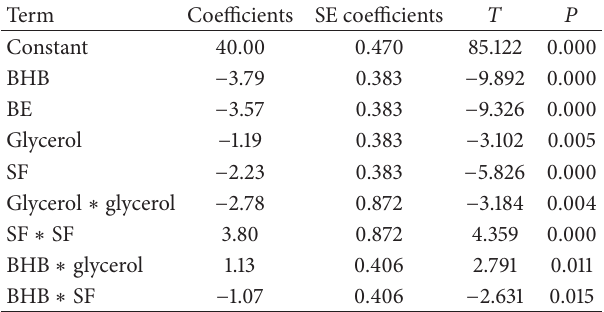
Table 4: Significant factors and their interactions—refitted RSM.